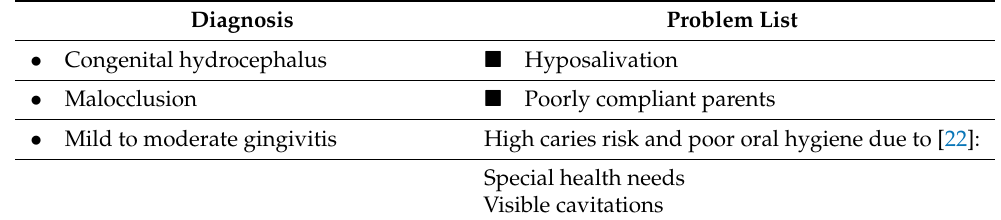
Table 2. A diagnosis and a problem list.